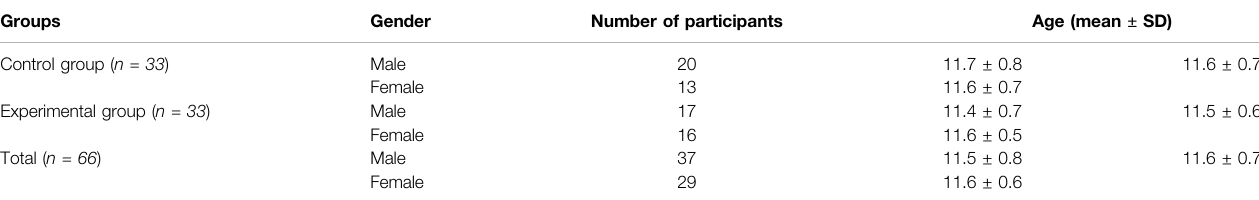
TABLE 1 | Distribution of all participants. Groups